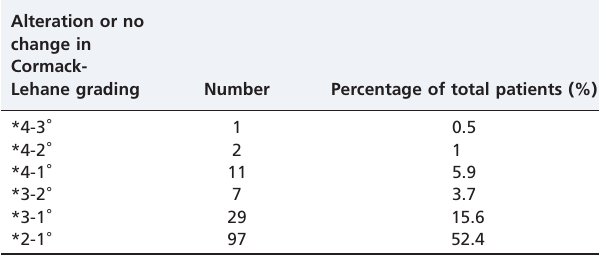
Table 1 - Baseline and demographic characteristics of the patients.